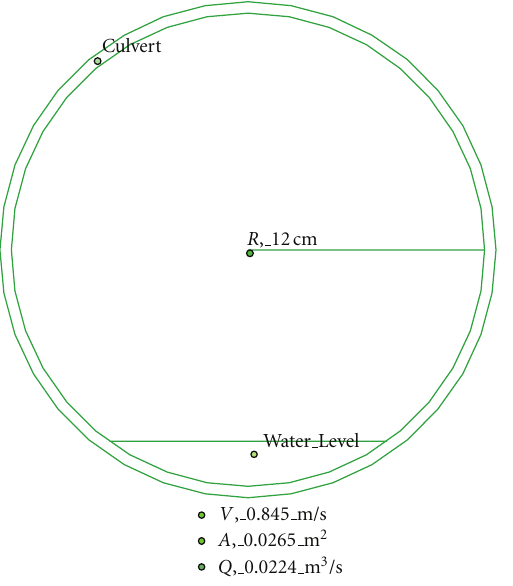
Figure 13: Map showing complete water discharge from catchment into River Ayer